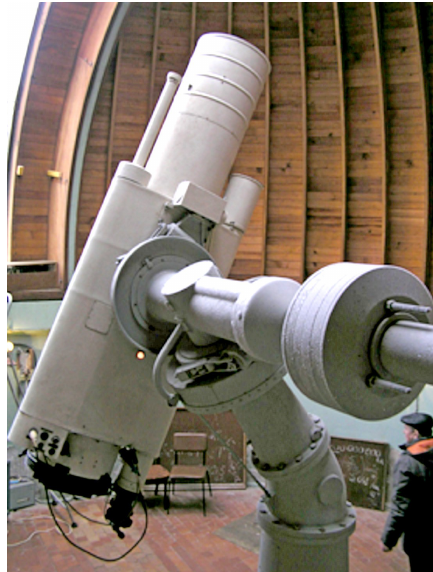
Fig. 1. The Carl Zeiss 40-cm astrograph on the broken